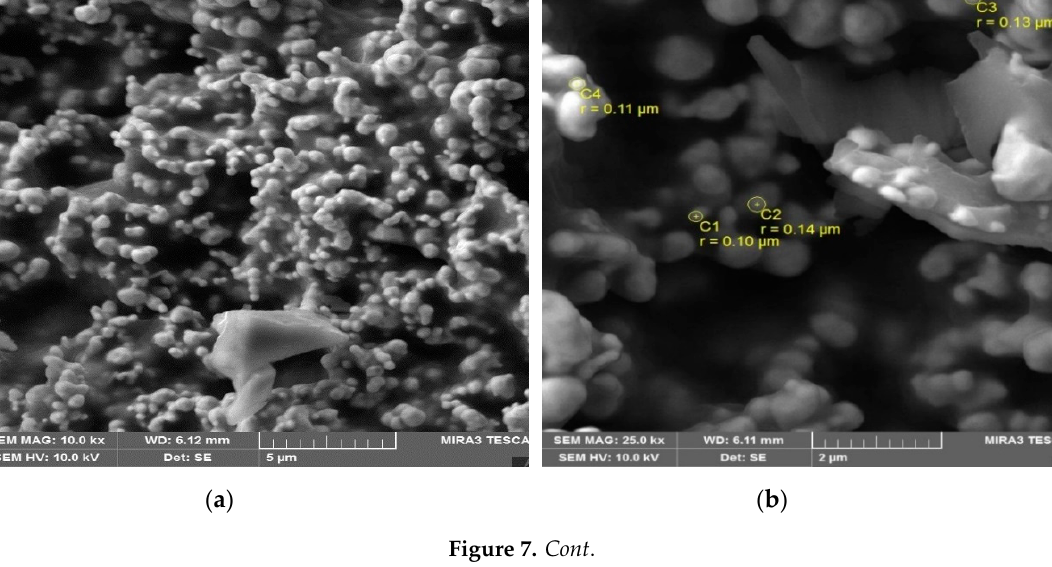
Figure 6. Film before and after heat treatment.